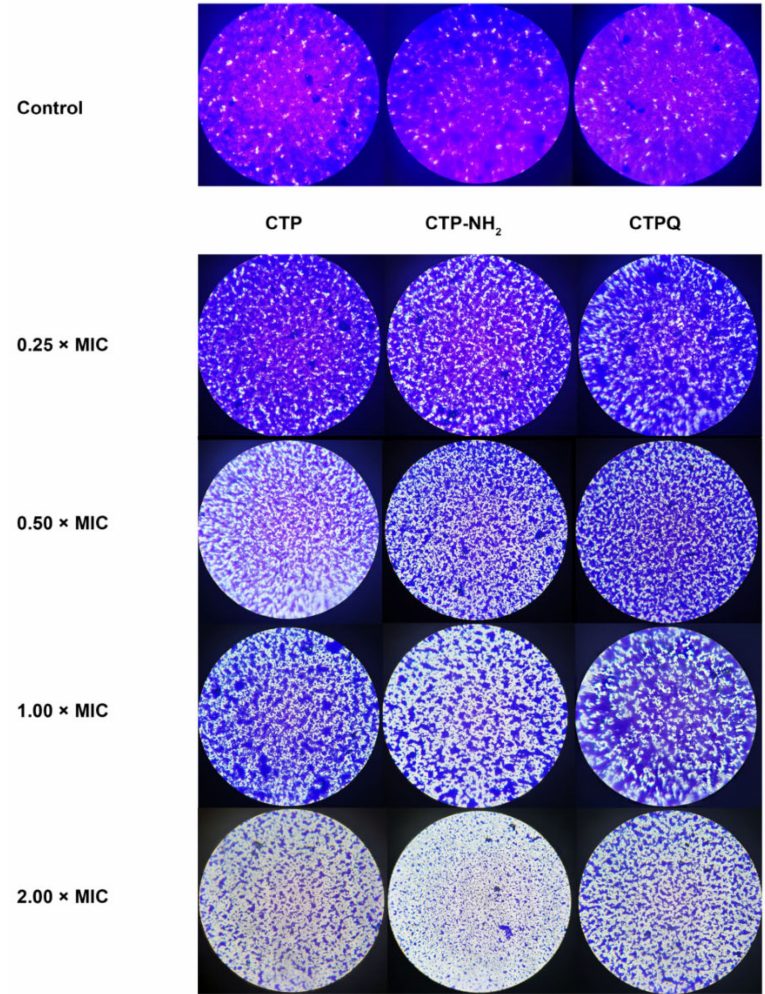
Figure 10. Optical microscope observation of S. aureus ATCC 43300 biofilm treated by CTPs (CTP, CTP-NH 2 , and